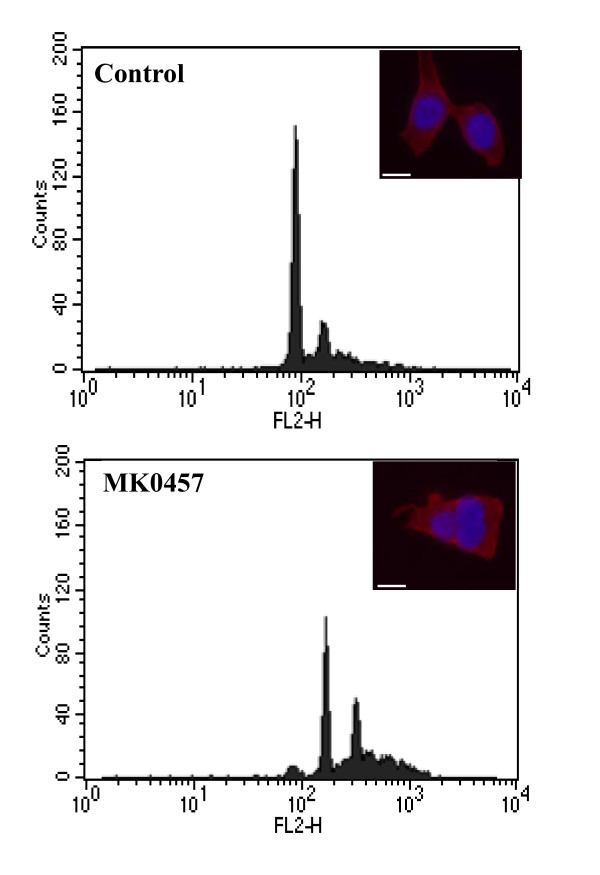
Effects of the MK-0457 on TT cell ploidy. Cells were incubated for 6 days with 200 nM MK-0457 or the vehicle (DMSO). At the end of the incubation time cells were fixed and analyzed by FACS. See also table 2. For the immunofluorescence experiments (insert) TT cells were exposed or not for 6 days to 200 nM MK-0457, then fixed and stained with DAPI and β-tubulin. Scale bar, 20 μm.